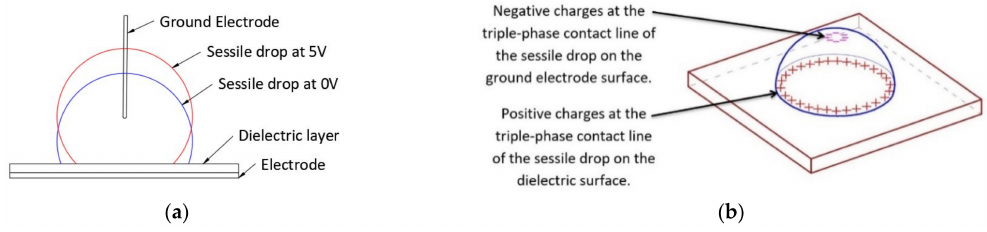
Figure 13. ( a ) Increase in contact angle of the sessile drop in the range of 0–5 V. ( b ) Dipole charges at the contact line of the sessile drop (when water acts as a conducting